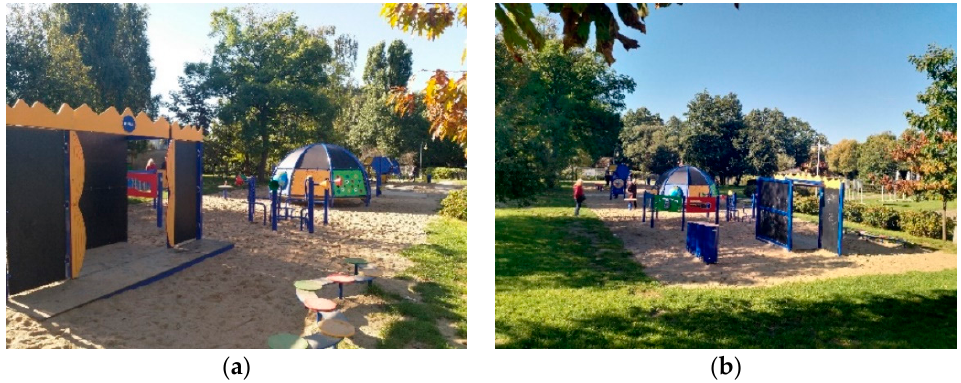
Figure 8. The talent playground in the summer of 2021 ( a , b ), source: author.